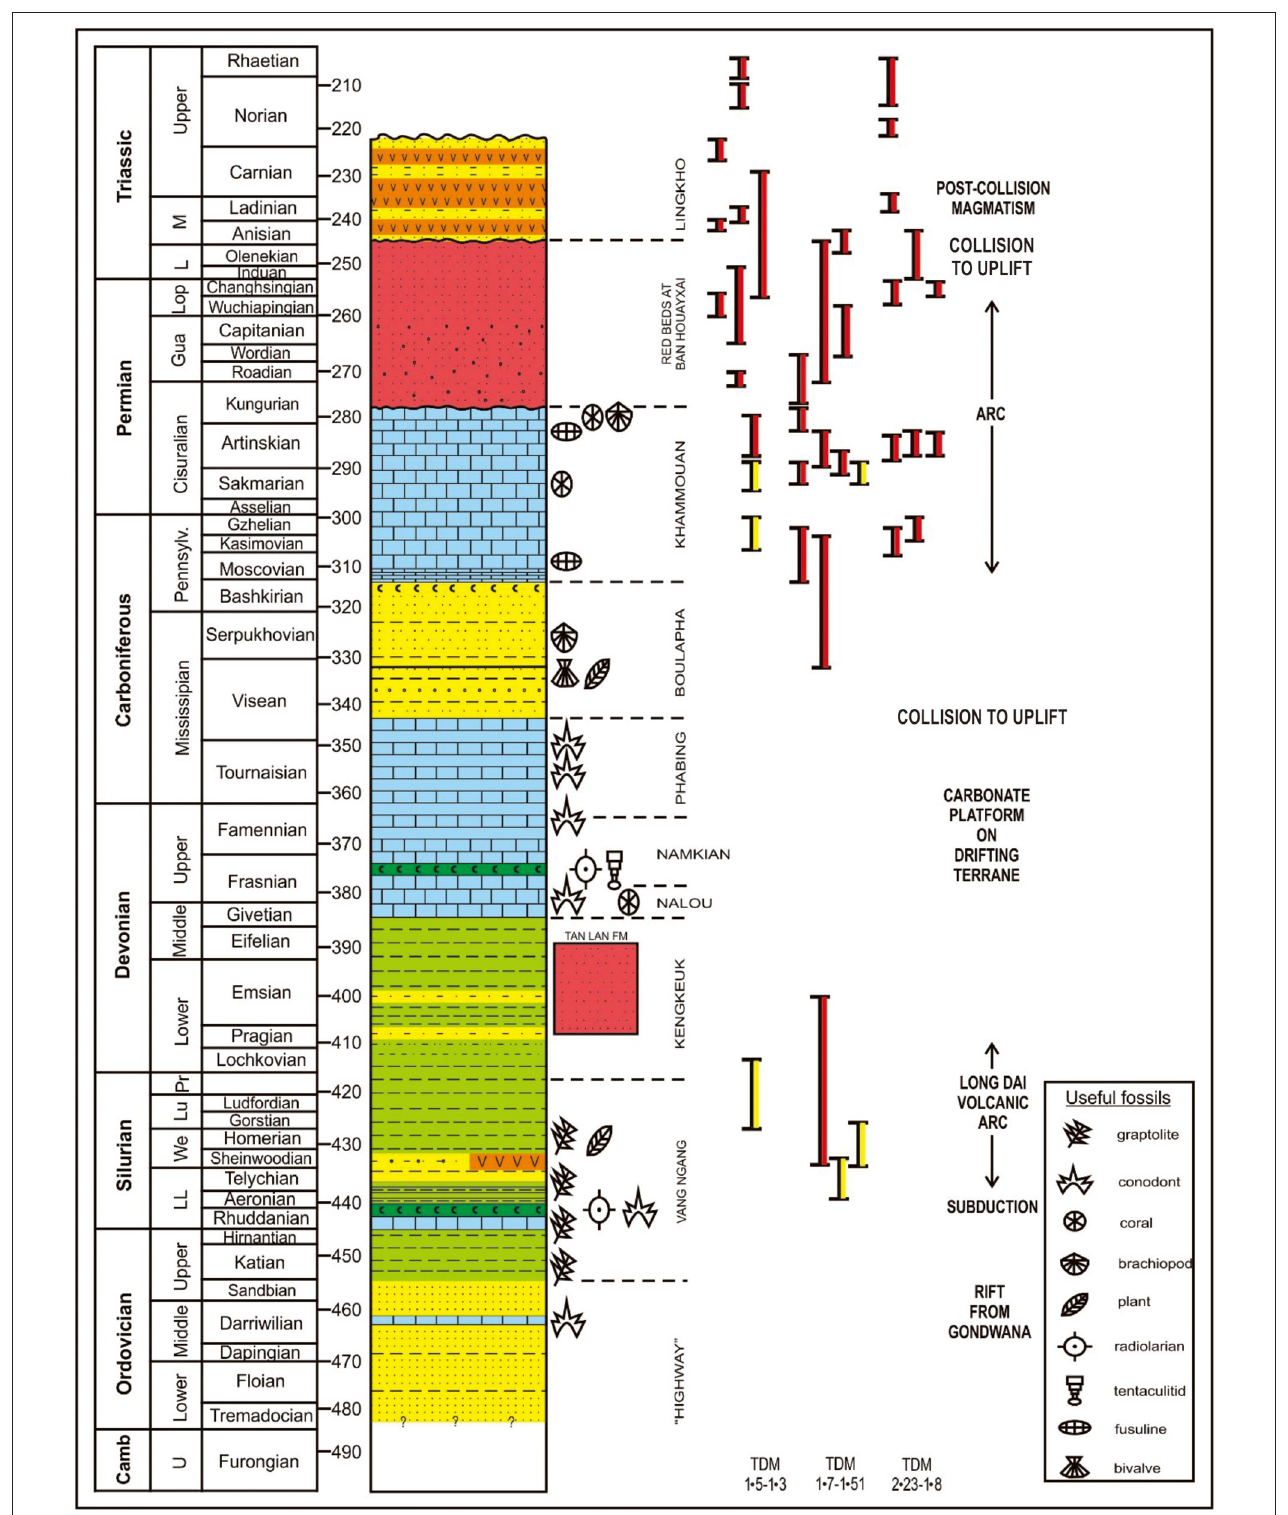
FIGURE 7 | Stratigraphic and plutonic igneous summary of the Truong Son Terrane based mainly on successions at well-dated formations at the Sepon Mine. The Tan Lam Formation in the Vietnamese sector of Truong Son represents the influx of coarse terrigenous siliciclastics caused by the first collision of the Truong Son and South China along the Song Ma Suture in the late Silurian to Early Devonian. Red lines are age ranges of felsic igneous rocks including granites and rhyolites. Yellow are andesites and diorites. Compiled from numerous sources.